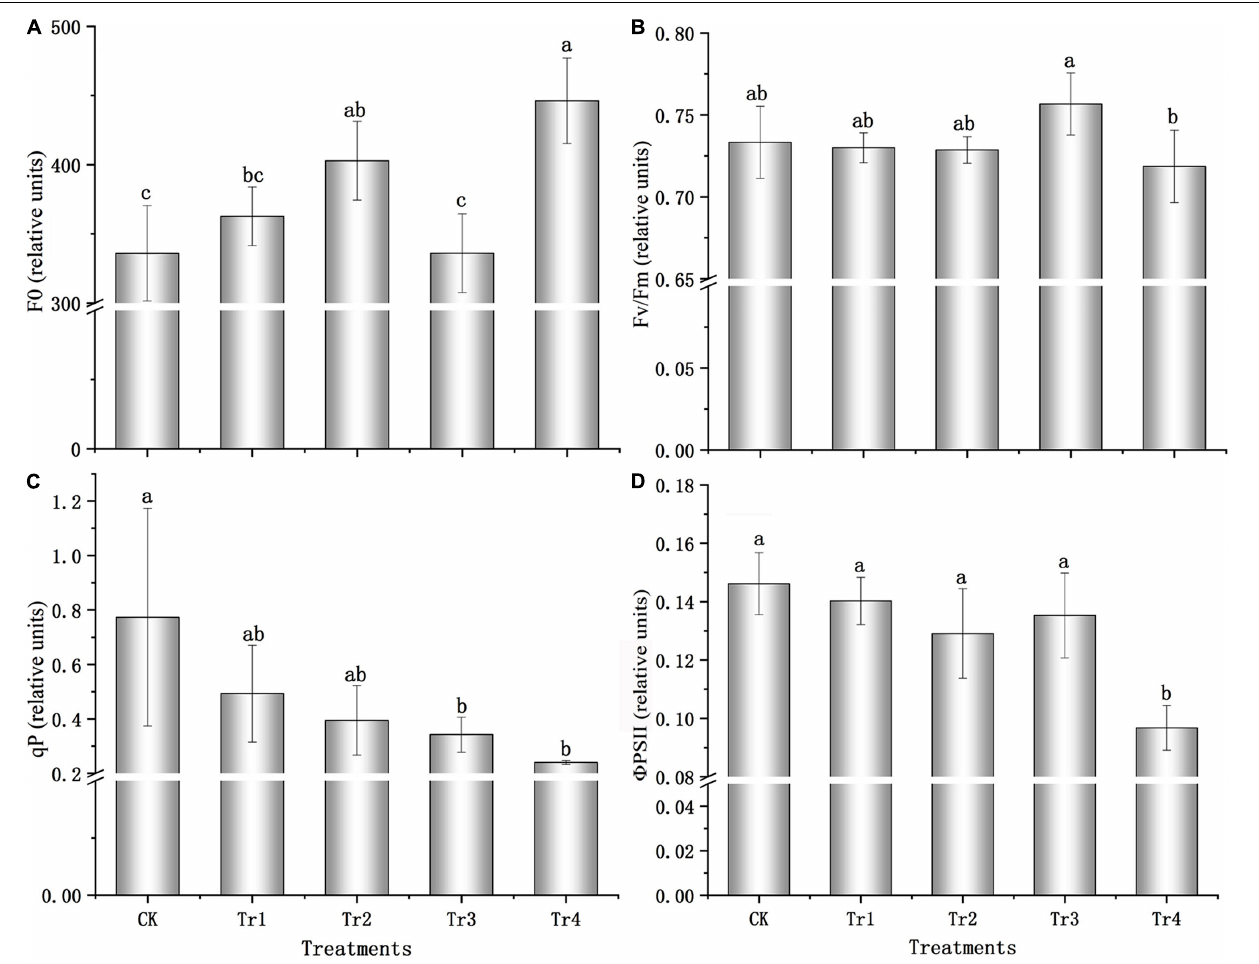
FIGURE 1 | Chlorophyll fluorescence characteristics of K. pentacarpos seedlings under saline–alkali stress. (A) Initial fluorescence (F 0 ). (B) Maximum photochemical efficiency (F v /F m ). (C) Photochemical quenching coefficient (qP). (D) PSII quantum yield ( (cid:56) PSII). Vertical bars in the figure indicate mean ± SD ( n = 3). Different letters indicate significant differences at P < 0.05.